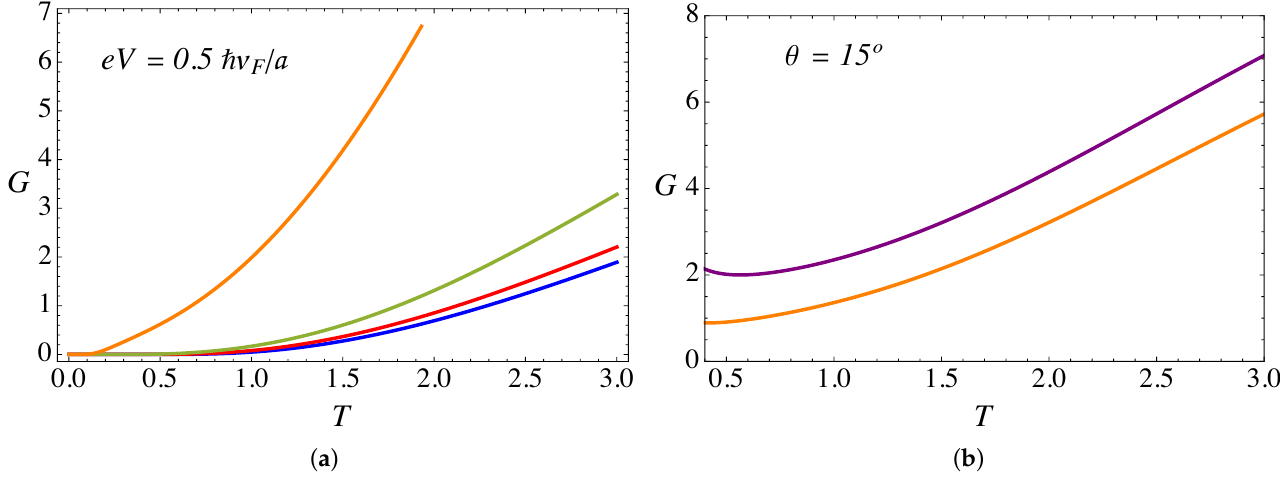
Figure 9. (Color online) ( a ) Conductance (in units of e 2 /¯ h ) as a function of temperature (in units of ¯ hv F / k B a ) for external B 0 a 2 = 25 ˜ φ 0 , a bias eV = 0.5 ¯ hv F / a , and α = 3 π /4. The blue line corresponds to θ = 0 ◦ , red is for θ = 5 ◦ , green is for θ = 10 ◦ , and the orange line corresponds to θ = 15 ◦ . ( b ) Comparison of conductance for θ = 15 ◦ : the purple line is for α = 0, whereas the orange line is for α = 3 π /4.